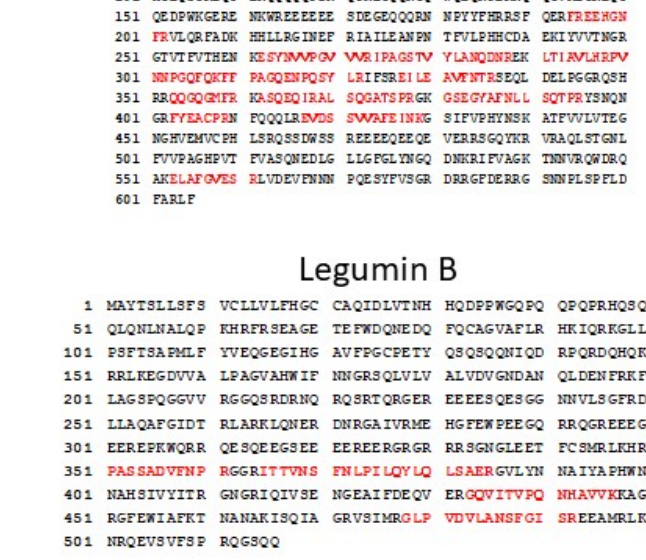
Figure 3. Peptides From the 49 and 51 kDa Bands Matching Cotton Vicilin and Legumin Proteins. Mass-spectrometry identified peptides from the 49 and 51 kDa bands that matched sequences from the cotton C72 and GC72-A vicilin and the legumin A and B proteins are colored red. 2.4. Cottonseed Vicilin and Legumin Contain Sequences Similar to Peanut and Tree Nut IgE Epitopes